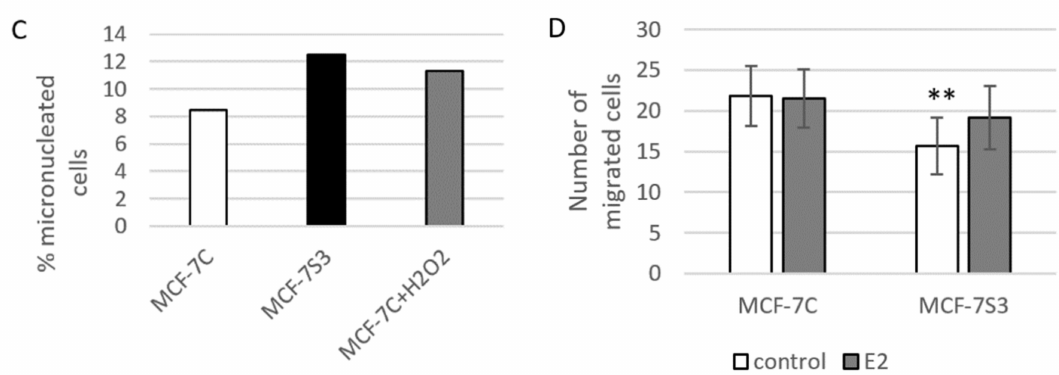
Figure 6. Sirt3 induces tumor-suppressive markers in MCF-7 cells. ( A ) Western blot analysis of proteins associated with tumor-suppressive function. Two-way ANOVA revealed a significant interaction e ff ect between Sirt3 and treatment on the p53 level F (2,12) = 118.1, p < 0.001, partial η 2 = 0.975; higher in the MCF-7S3 control and E2-treated (*** p < 0.001) and E2 + ICI-treated (** p < 0.01) vs. MCF-7C. In MCF-7C, higher in the E2 ( a p < 0.05) and E2 + ICI-treated ( b p < 0.001) vs. the control. In MCF-7S3, lower in the E2 and E2 + ICI-treated vs. the control ( c,d p < 0.01). For AIF, two-way ANOVA revealed a significant interaction e ff ect between Sirt3 and treatment F (2,12) = 187.56, p < 0.001, partial η 2 = 0.984; *** p < 0.001 MCF-7S3 vs. MCF-7C. In MCF-7C, higher in the E2 and E2 + ICI-treated vs. the control ( a,b p < 0.001). In MCF-7S3, higher in the E2 and E2 + ICI-treated vs. the control ( c,d p < 0.001). For phospho- γ H2AX, two-way ANOVA revealed significant interaction e ff ect between Sirt3 and treatment F (2,12) = 5.39, p < 0.05, partial η 2 = 0.642; the MCF-7S3 control (*** p < 0.001), E2 (** p < 0.01), and E2 + ICI-treated (* p < 0.05) vs. MCF-7C. In MCF-7C, lower in E2 vs. the control ( a p < 0.05) and E2 + ICI-treated ( b p < 0.01). In MCF-7S3, lower in E2 vs. the control ( c p < 0.001) and E2 + ICI-treated ( d p < 0.01). Results are shown as mean ± SD ( n ≥ 3). Amidoblack was used as a loading control; ( B ) Confocal imaging of phospho- γ H2AX signal abundance as a marker of DNA damage in MCF-7C and MCF-7S3 cells with or without E2 treatment. Bar represents 10 µ m; ( C ) Graphical chart of frequency of micronucleated cells in MCF-7C and MCF-7S3 cells, as well as in MCF-7C cells treated with H 2 O 2 as a positive control. The experiments were repeated at least three times and representative data are shown; ( D ) Graphical chart of number of migrated MCF-7C and MCF-7S3 cells with or without E2 treatment. Two-way ANOVA revealed a significant e ff ect of Sirt3 on migration rate F (1,23) = 1.812, p = 0.007, partial η 2 = 0.279; lower in MCF-7S3 vs. MCF-7C cells (** p = 0.007). Results are shown as mean ± SD ( n ≥